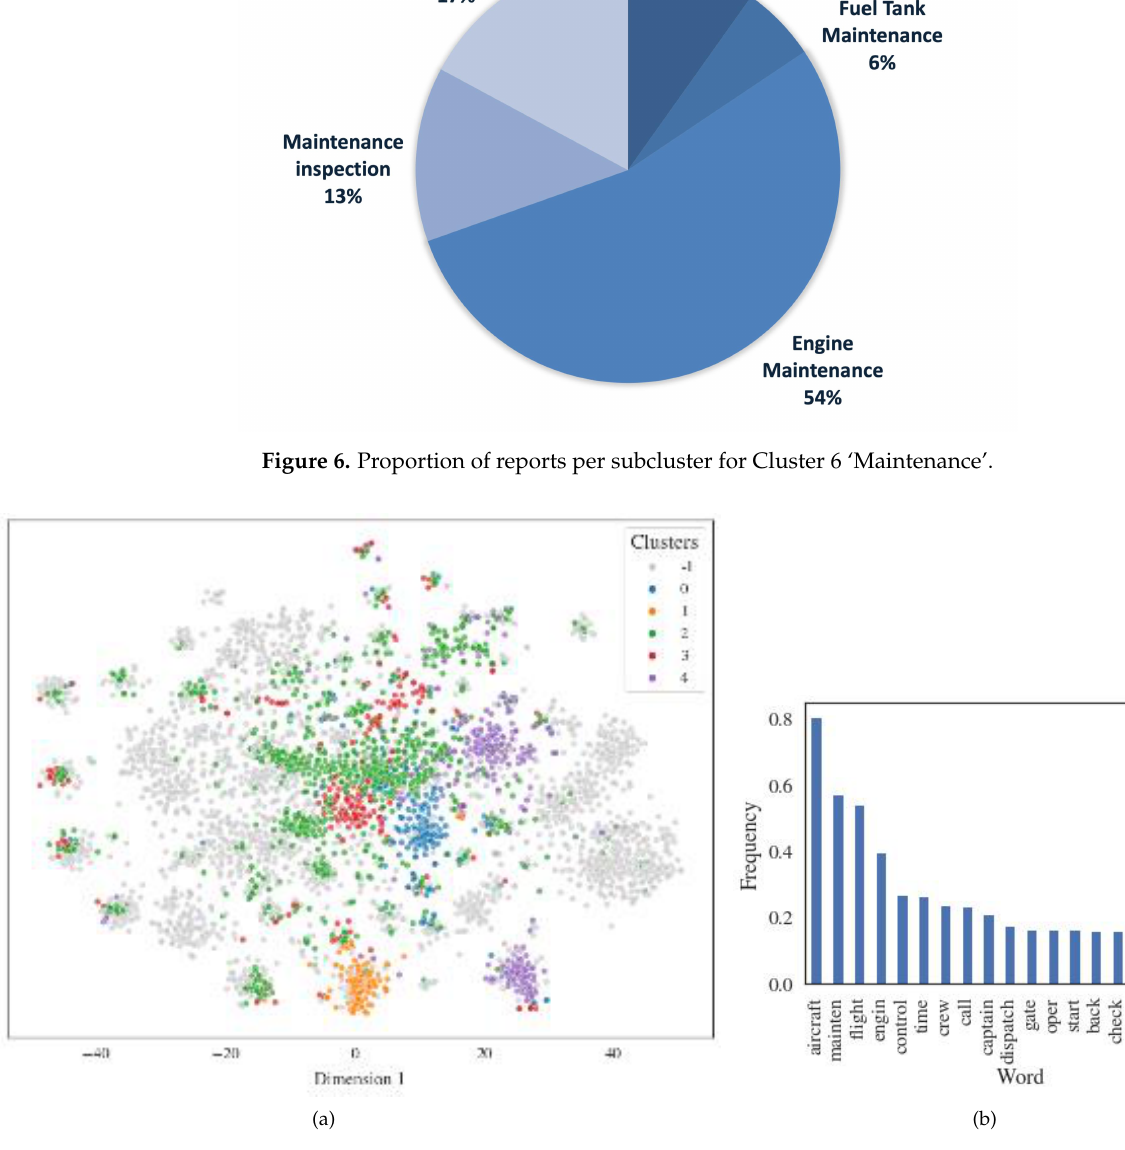
Figure 7. ( a ) t-SNE visualization of the Cluster 6 subclusters. ( b ) Most frequent words in Cluster 6.2 with the topic ’Engine